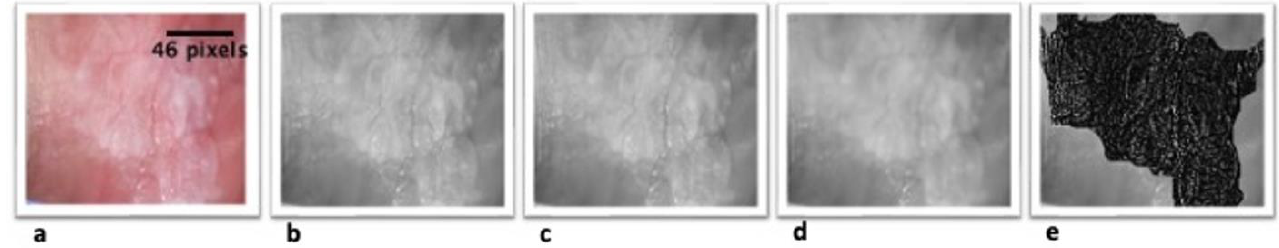
Figure 2. Binary process and filtering of the photographic image. ( a ) Digital cropped image of the buccal mucosa of a patient diagnosed with oral leukoplakia. ( b ) The cropped image, converted into an 8-bit image. ( c ) Image with added sharpening to make the lesion clearer, ( d ) Adding smoothing of the image. ( e ) A convolution filter was applied to define the limits of the lesion and crop the lesion image.